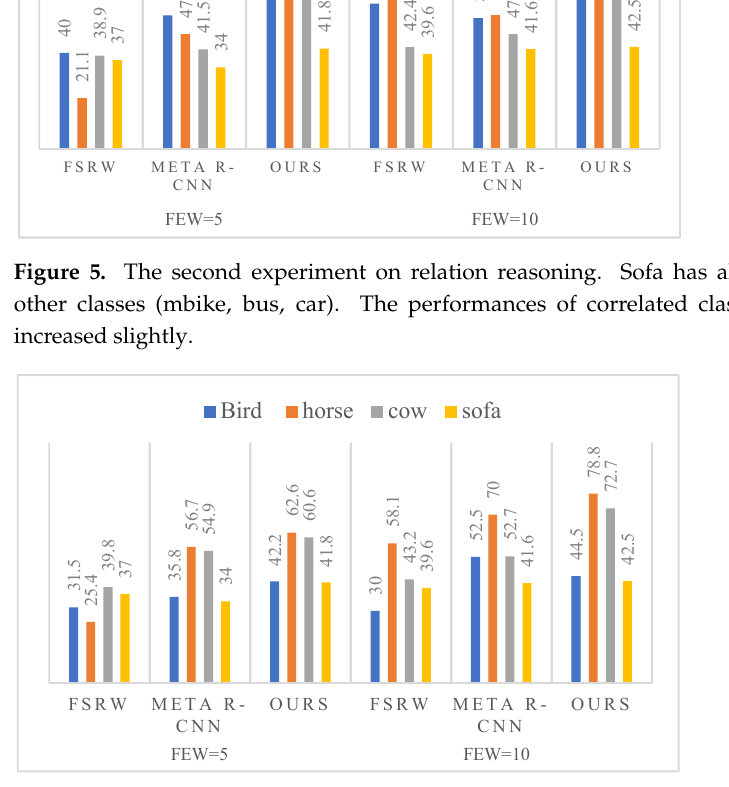
Figure 6. The third experiment on relation reasoning. Sofa almost has no association with other classes (bird, horse, cow). The performances of correlated classes (horse, cow) are increased slightly.